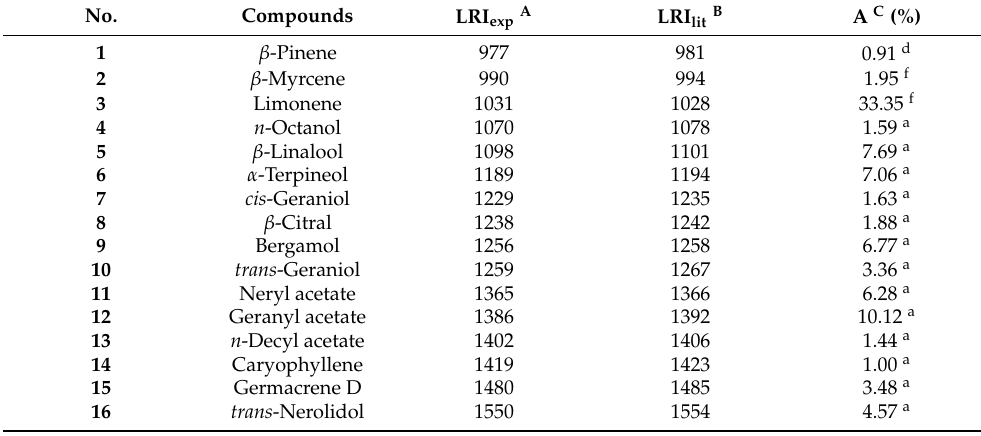
Table 1. Chemical composition of the EO of the flavedo of C. aurantium ‘Crispifolia’ from Palermo, Sicily